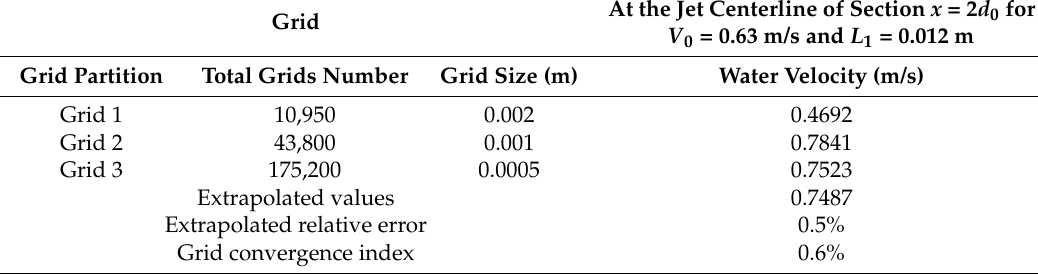
Table 1. The analysis of discretization error.